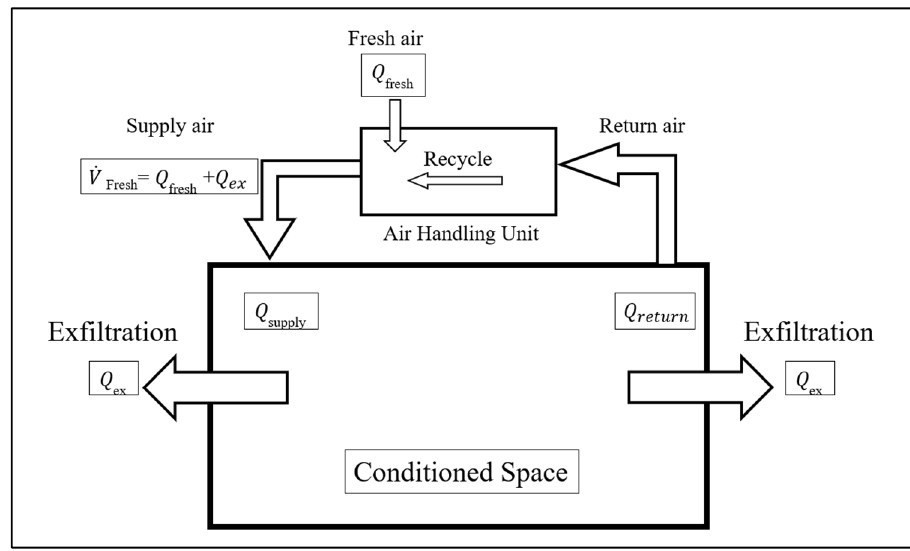
Figure 13. Air leakage behavior. Table 7 lists the values of the air leakage coefficient C, pressure exponent n , air leakage